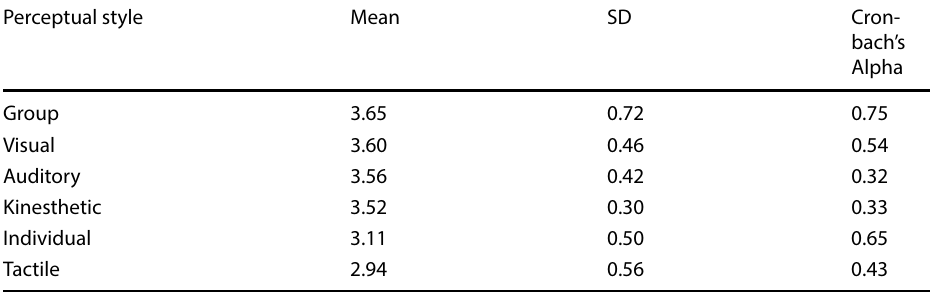
Table 1 Perceptual teaching style profile of